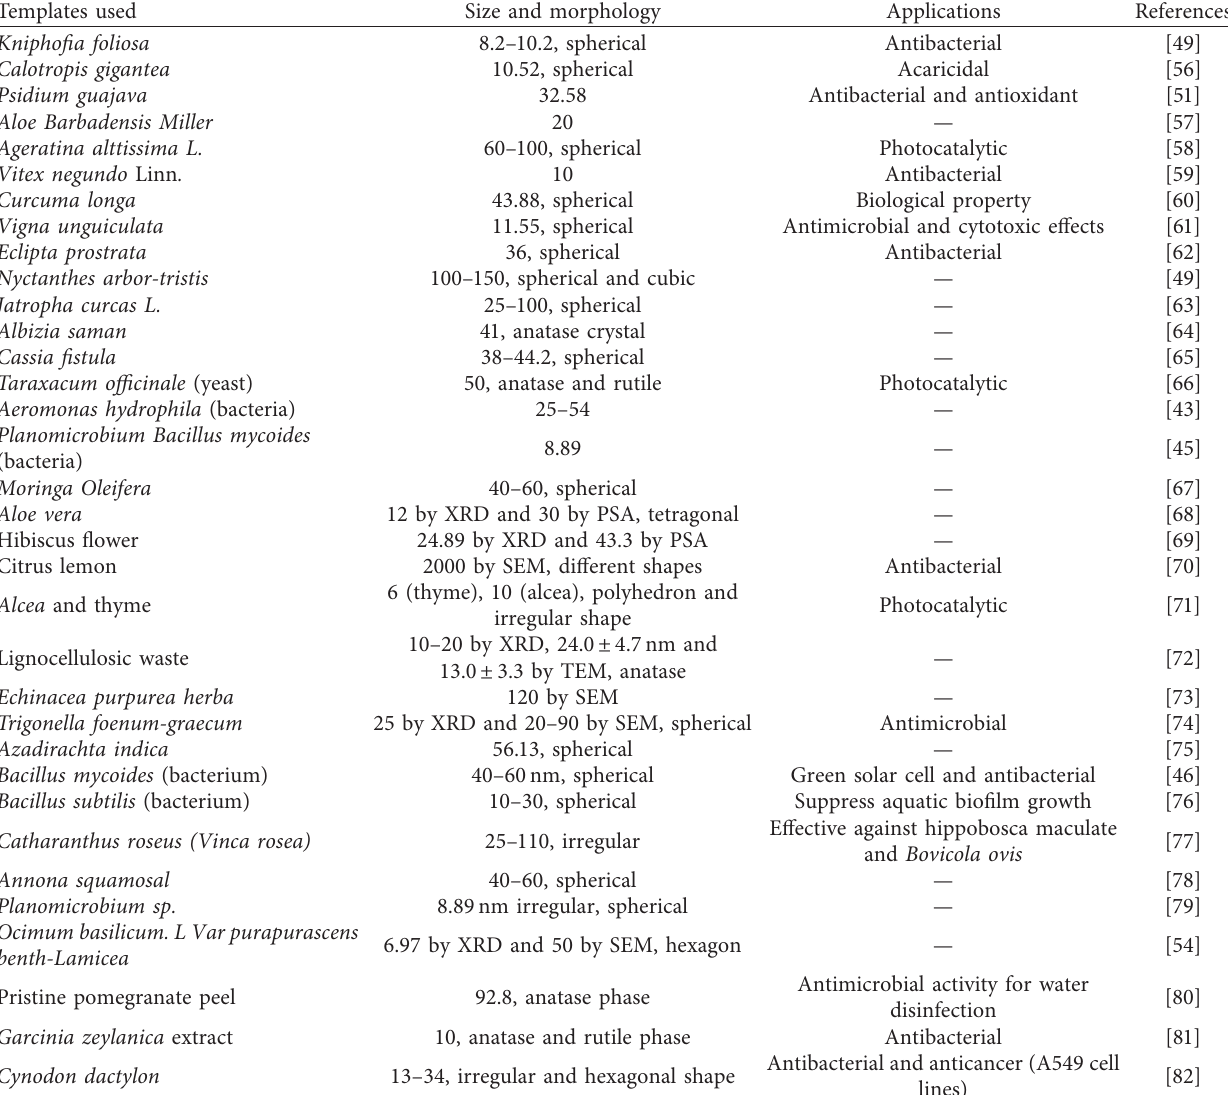
Table 1: Summary of the biogenic synthesis of TiO